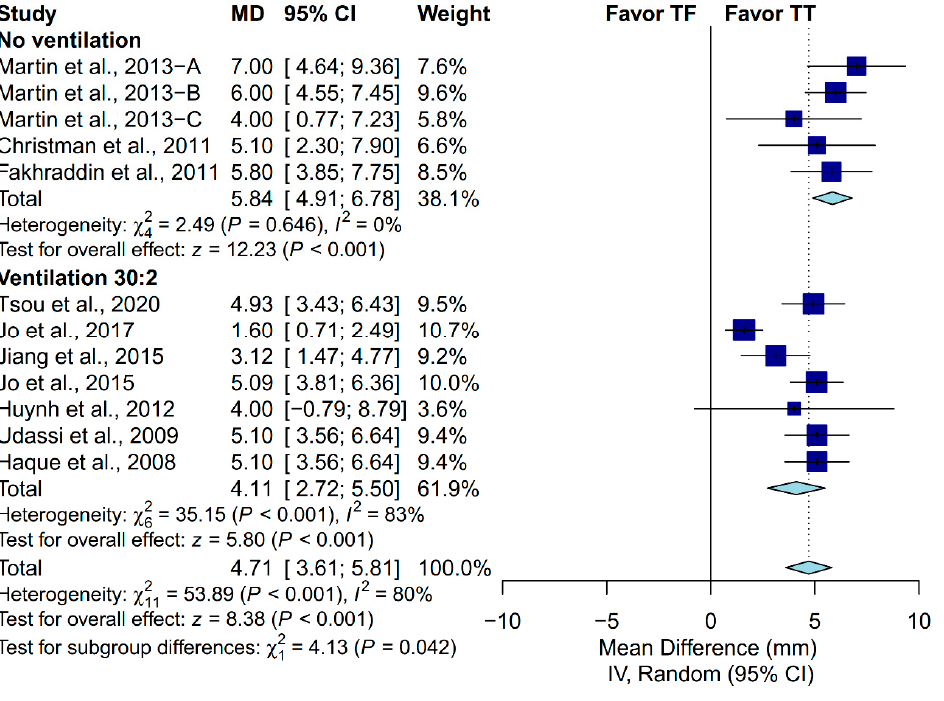
Int. J. Environ. Res. Public Health 2020 , 17 , x FOR PEER REVIEW Figure 5. Subgroup analysis of chest-compression depth grouped by ventilation protocol.